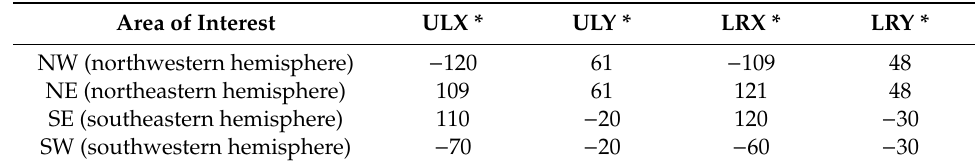
Table 1. Coordinates of the extents of four AOIs that were used to evaluate our proposed algorithm in selecting appropriate swath data